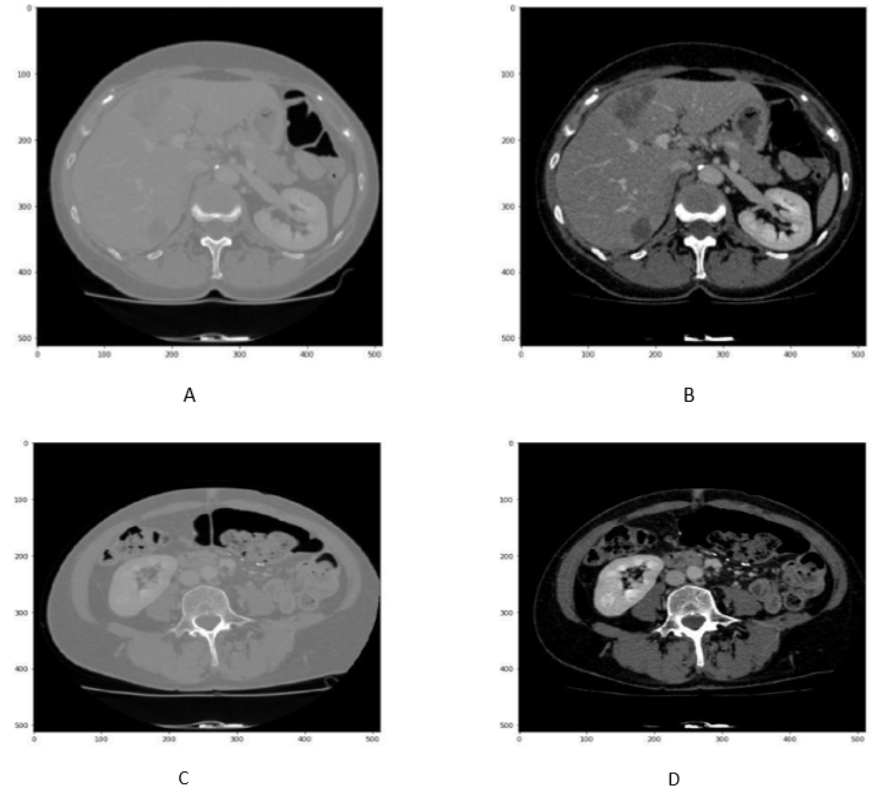
Figure 2. Figure represents the HU windoing results in ( A , B ) , While Figures ( C , D ) shows the HU windowing results not having